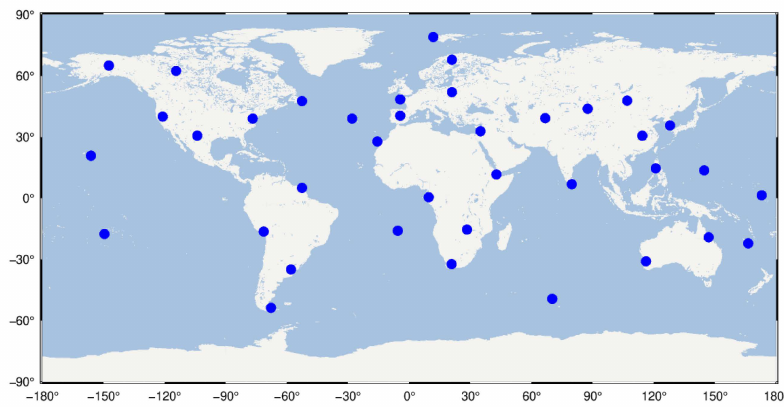
Figure 8. Distribution of the test stations.